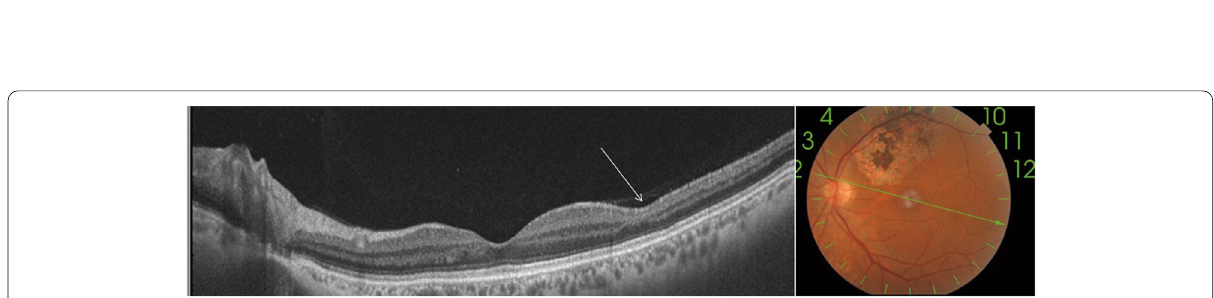
Fig. 5 Swept source-OCT scan taken at the same time shows the disappearance of the band-like hyper-reflectivity corresponding to PAMM and a focal area of inner retinal thinning corresponding to a resolved retinal infiltrate